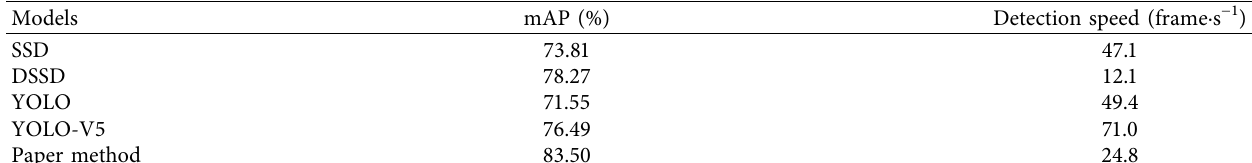
Table 2: Comparison of feature extraction time and pattern recognition